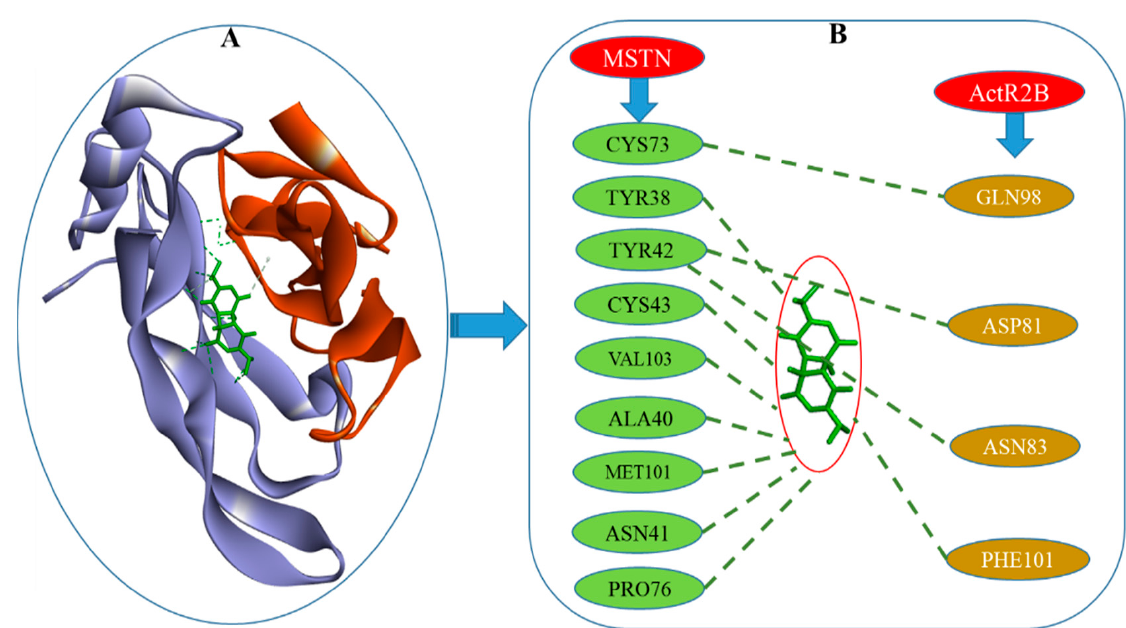
Figure 6. PPI diagram: ( A ) The structure of the MSTN–DTQ–ActR2B complex. ( B ) Amino acid residues that interact in MSTN–DTQ–ActR2B.